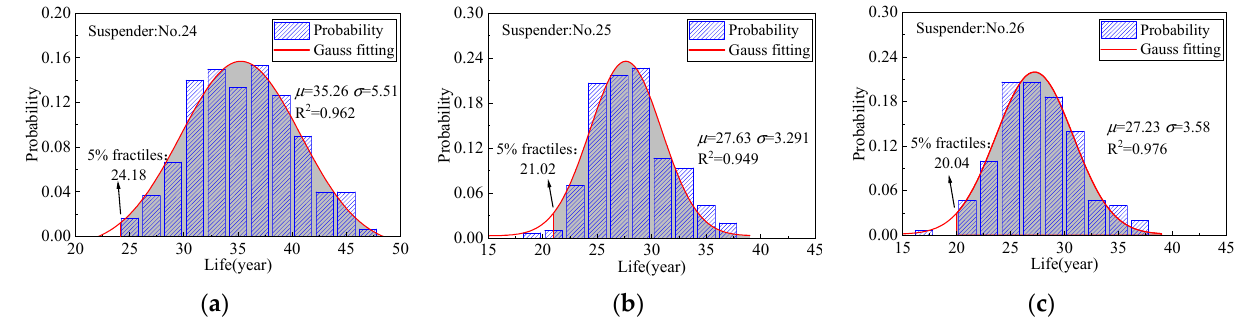
Figure 17. Distribution of steel wire life under the N-C condition. ( a ) Suspender no. 24; ( b ) suspender no. 25; ( c ) suspender no. 26.